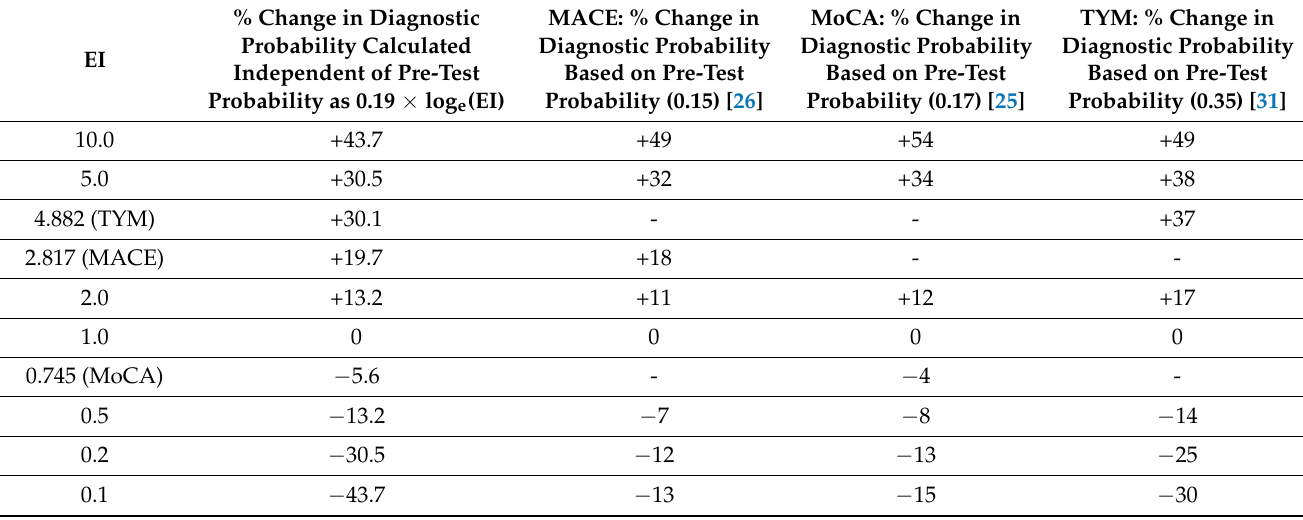
Table 5. EI values calculated independent of pre-test probability and for selected cognitive screening instruments based on pre-test probability observed in test accuracy